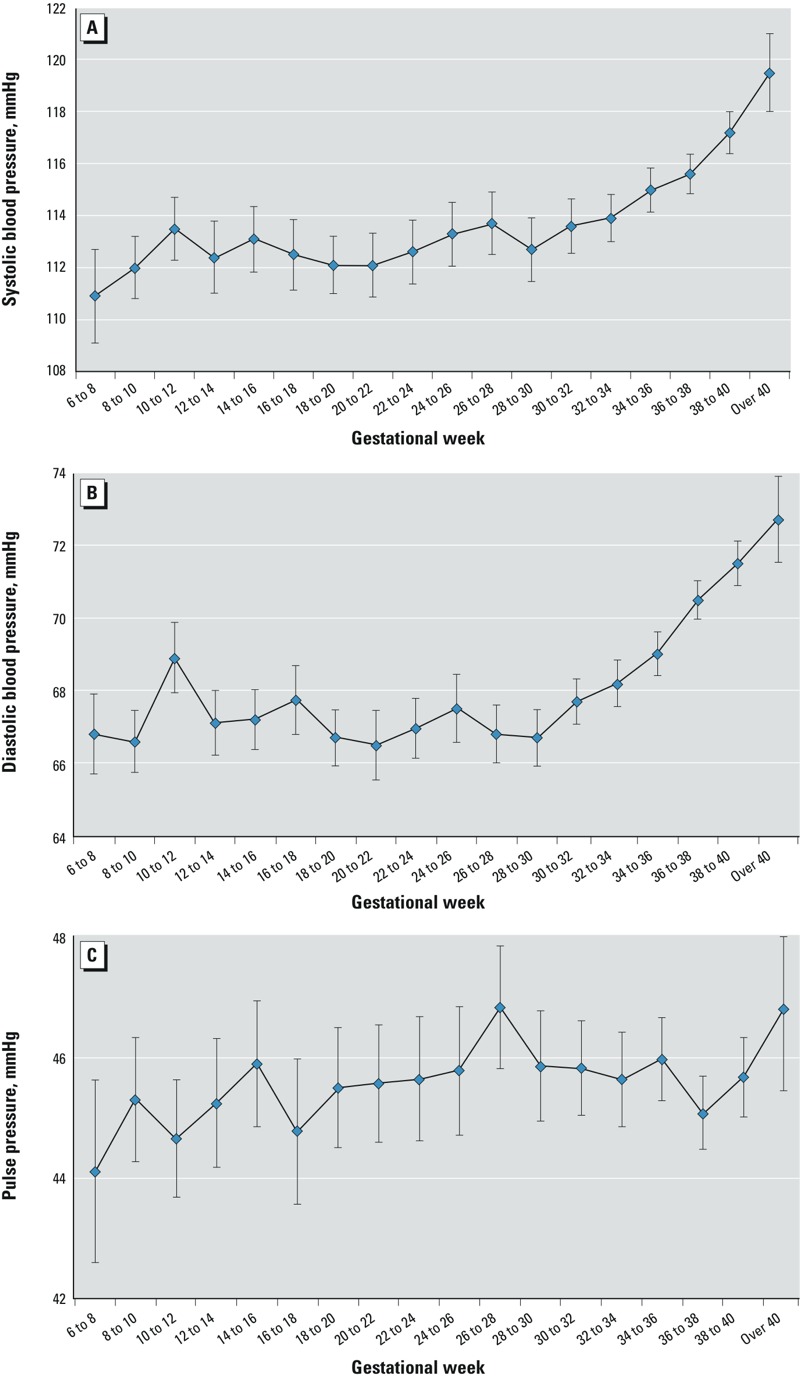
Blood pressure measurements over pregnancy by gestational week. For each 2-week period, all systolic blood pressure (A), diastolic blood pressure (B), or pulse pressure (C) measurements during that time were averaged individually for each woman and then averaged across all women and plotted. Error bars represent the 95% CIs. Measurements prior to 6 weeks of gestation were excluded due to few available measurements.